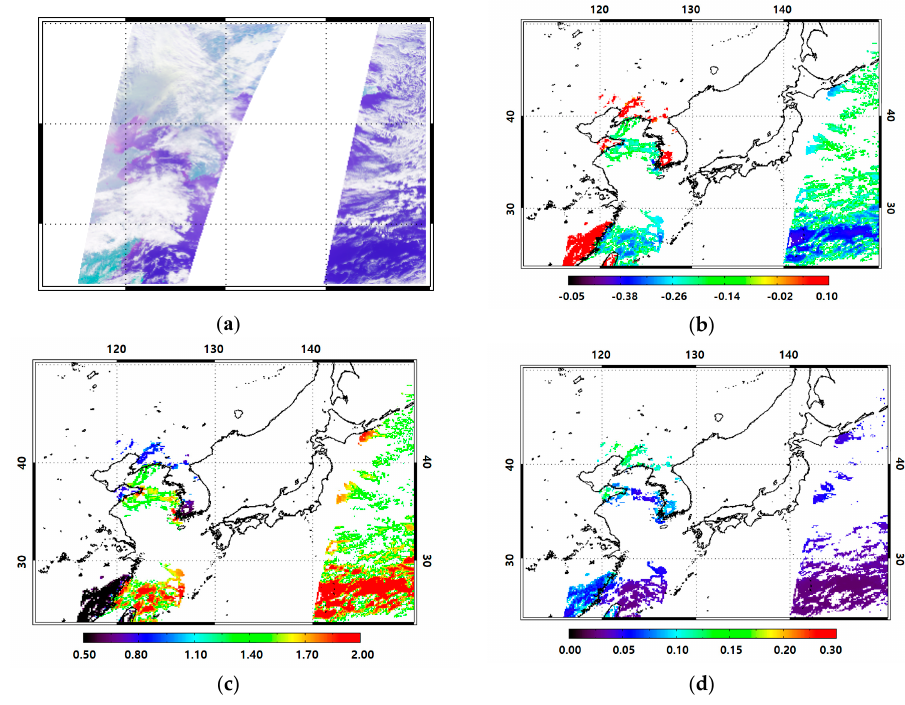
Figure 1. An example of the ( a ) TANSO-CAI false color image; ( b ) NDVI; ( c ) ratio of band 2/band 3, and ( d ) reflectance after cloud mask using NDVI and reflectance ratio at bands 2 and 3 from TANSO-CAI with 0.1° grid pixel resolution on 24 December 2009. The white area represents that lack of observation swath of TANSO-CAI and masked region by cloud masking method in the TANSO-CAI aerosol algorithm.